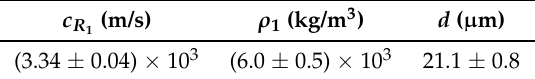
Table 3. Average value and topographic variation of each best fitting parameter along the scanned surface area of the GESA modified coating—T91 steel substrate sample.